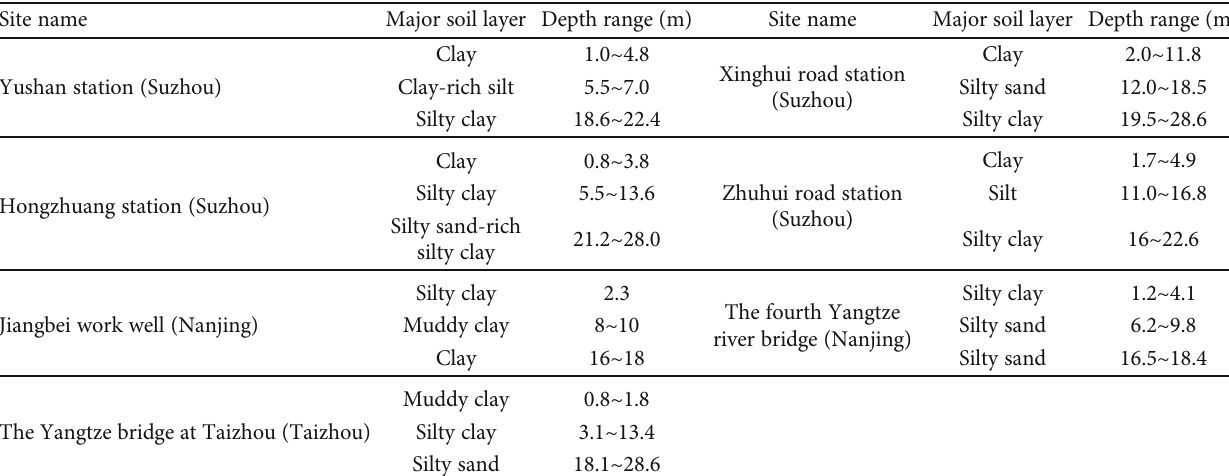
and ellipse are presented in terms of dash-dotted line, dot- ted line, and heavy solid line shown in Figure 1. Through curve fi tting, the “ best- fi t ” expressions for the arc, parabola, and ellipse to the data collected by Elsworth and Lee [15] are given by